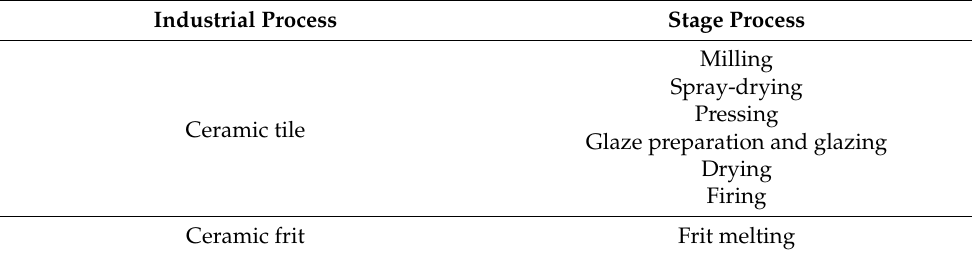
Table 2. Industrial